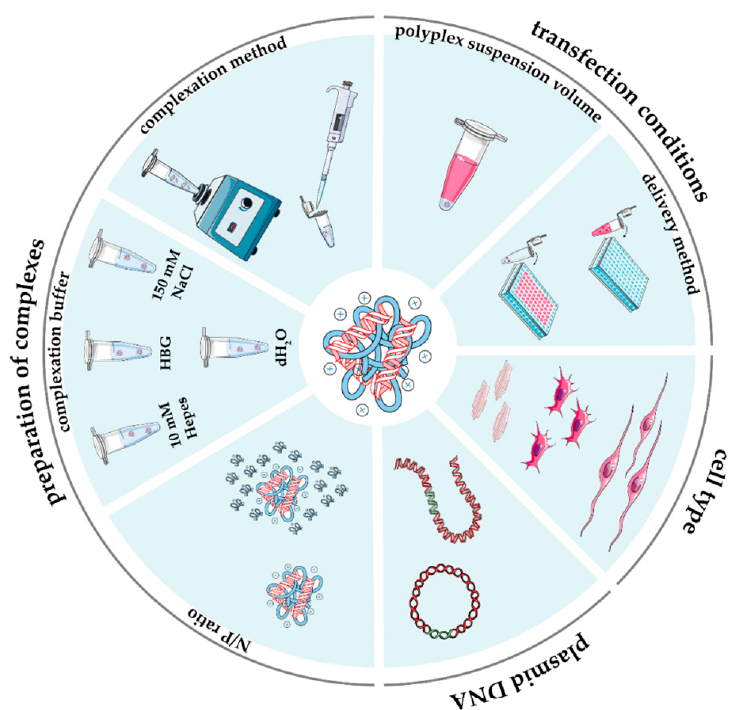
Figure 1. Main experimental parameters influencing the in vitro performance of gene delivery vectors.